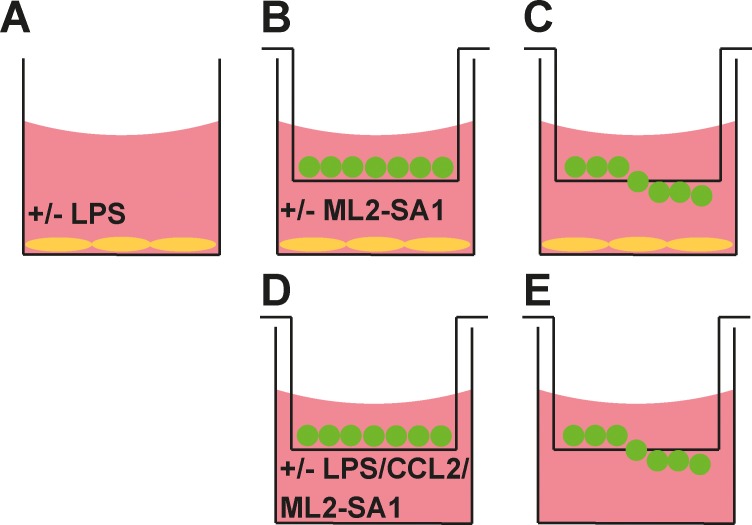
Modified and classical Boyden chamber setup.In the modified Boyden chamber setup (A–C) BMDMΦ plated on poly-L-lysine coated cover slips in a twenty-four well plate are treated with 1 µg/mL LPS or equal volume of DMSO for 6 hr (A). After 6 hr media is replaced for media containing 10 or 30 µM ML2-SA1 or equal volume of DMSO and a transwell chamber containing 1 × 105 BMDMΦ is inserted (B). After 3 hr migration, cells translocated through the transwell chamber and stick to the bottom (C). In the classical Boyden chamber setup (D–E) a twenty-four well plate is filled with media containing either DMSO, 1 µg/mL LPS and DMSO, 1 µg/mL LPS and 30 µM ML2-SA1, or 10 ng/mL CCL2 and a transwell chamber containing 1 × 105 BMDMΦ is inserted (D). After 3 hr migration, cells translocated through the transwell chamber and stick to the bottom (E). Migrated cells can be fixed and stained with crystal violet for quantification of cell covered area.